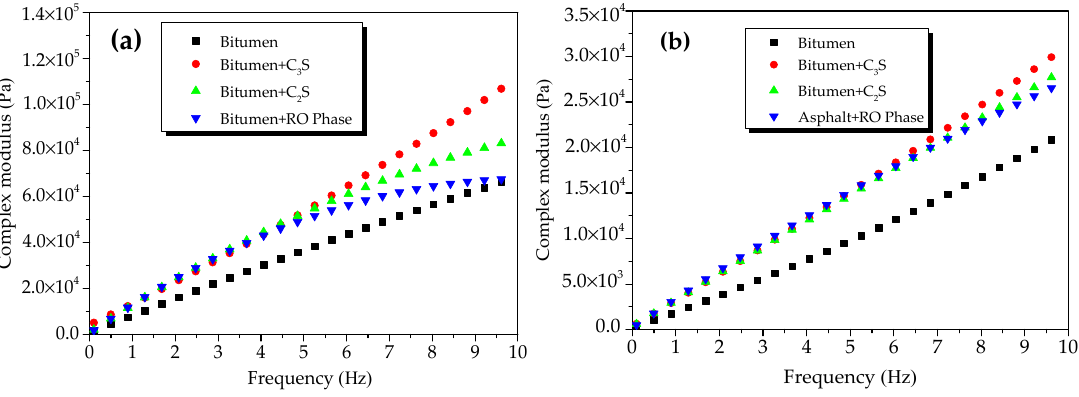
Figure 10. Complex shear modulus of mixtures of bitumen–mineral components of steel slag at different temperatures: ( a ) 45 °C and ( b ) 55 °C.